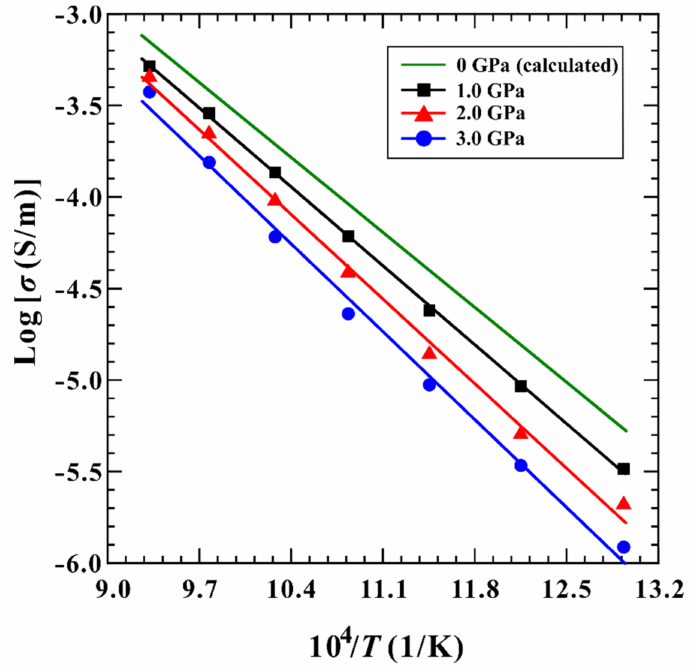
Figure 6. Influence of pressure on the electrical conductivity of dry hot-pressed sintering gabbro ( Cpx 50 Pl 50 ) at the temperature ranges of 773–1073